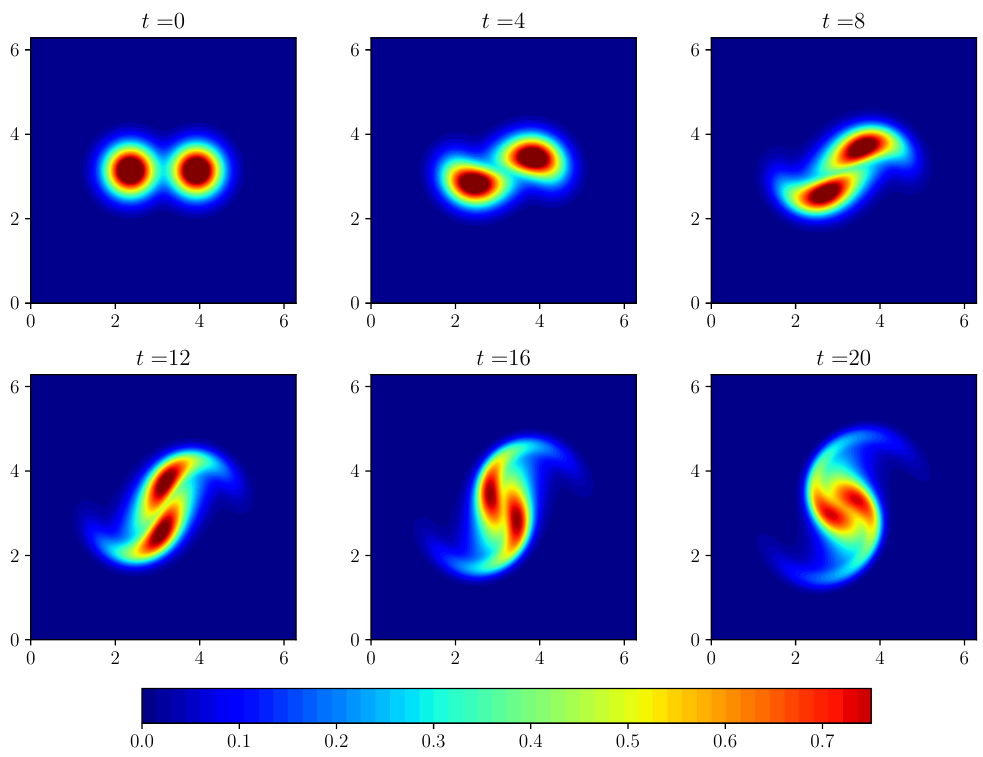
Figure 3. Evolution of the merging of two co-rotating vortices without any source term (i.e., Π = 0) at Reynolds number Re = 1000.